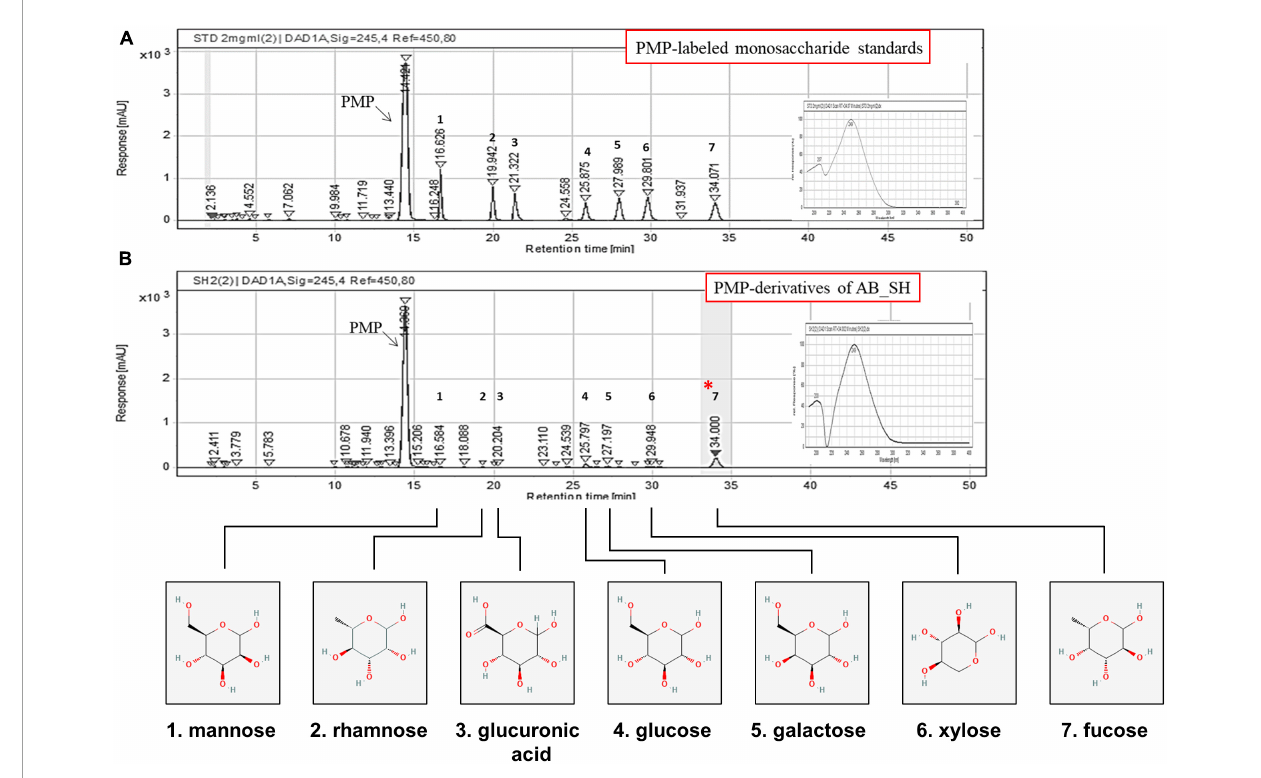
FIGURE4 Composition analysis and structures of the major polysaccharides in AB_SH. Chromatograms of (A) PMP-labeled sugar standards and (B) PMP-derivatives of acid hydrolysates of AB_SH.